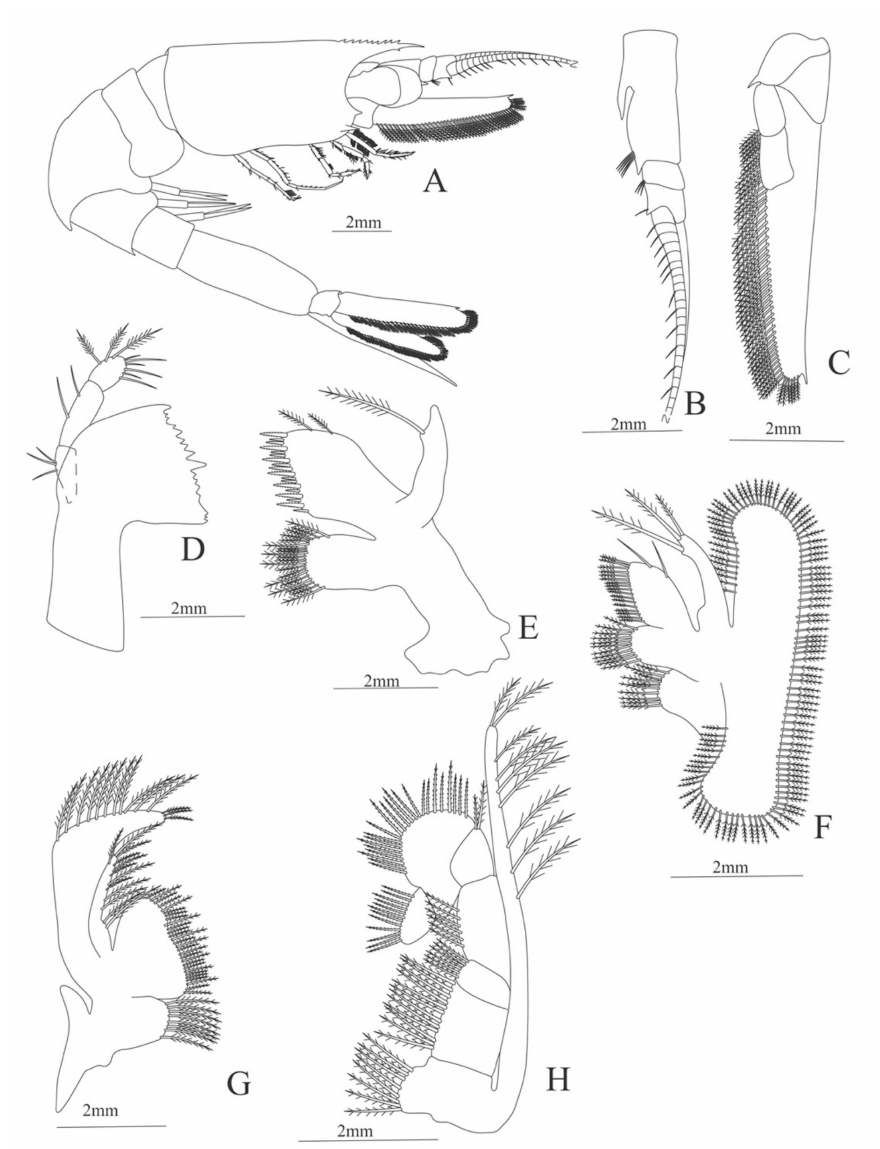
Figure 17. Systellaspis braueri : ( A ) lateral view; ( B ) antennule; ( C ) antenna; ( D ) mandible; ( E ) maxillule; ( F ) maxilla; ( G ) first maxilliped; ( H ) second maxilliped. Fifth pereopod (Figure 18E). Coxa and basis without setae; endopod 5-segmented with 5 (2 spine + 4 simple setae), 2, 3, 12, 8 simple setae; exopod unsegmented and unarmed. Uropod (Figure 18F). Endopod well developed with 54 plumose setae; exopod with 42 plumose setae Telson (Figure 18G) elongate, subtriangular, with 11 pairs of lateral spines, 1 pair of large mobile spines and 10 pairs of spines on the distal part near the tip of the telson; one small spine on the distal